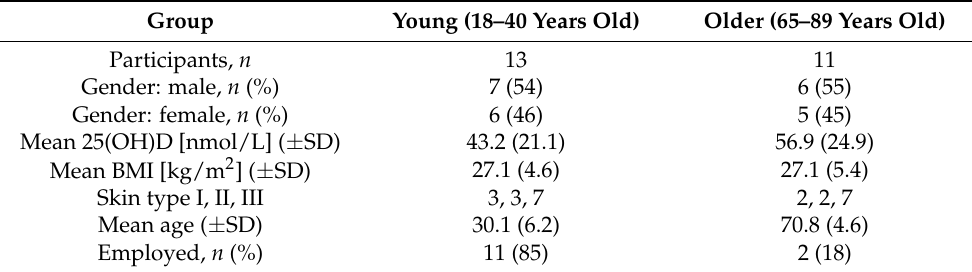
Table 3. Patient Demographics. Mean values unless otherwise stated. Healthy BMI range 18.5–25 kg/m 2 . Deficiency of vitamin D defined as below 25 nmol/L (10 ng/mL); sufficiency defined as 50 nmol/L (30 ng/mL) and above, of 25(OH)D [2]. Skin type I, II, III based on Fitzpatrick phototype assessment